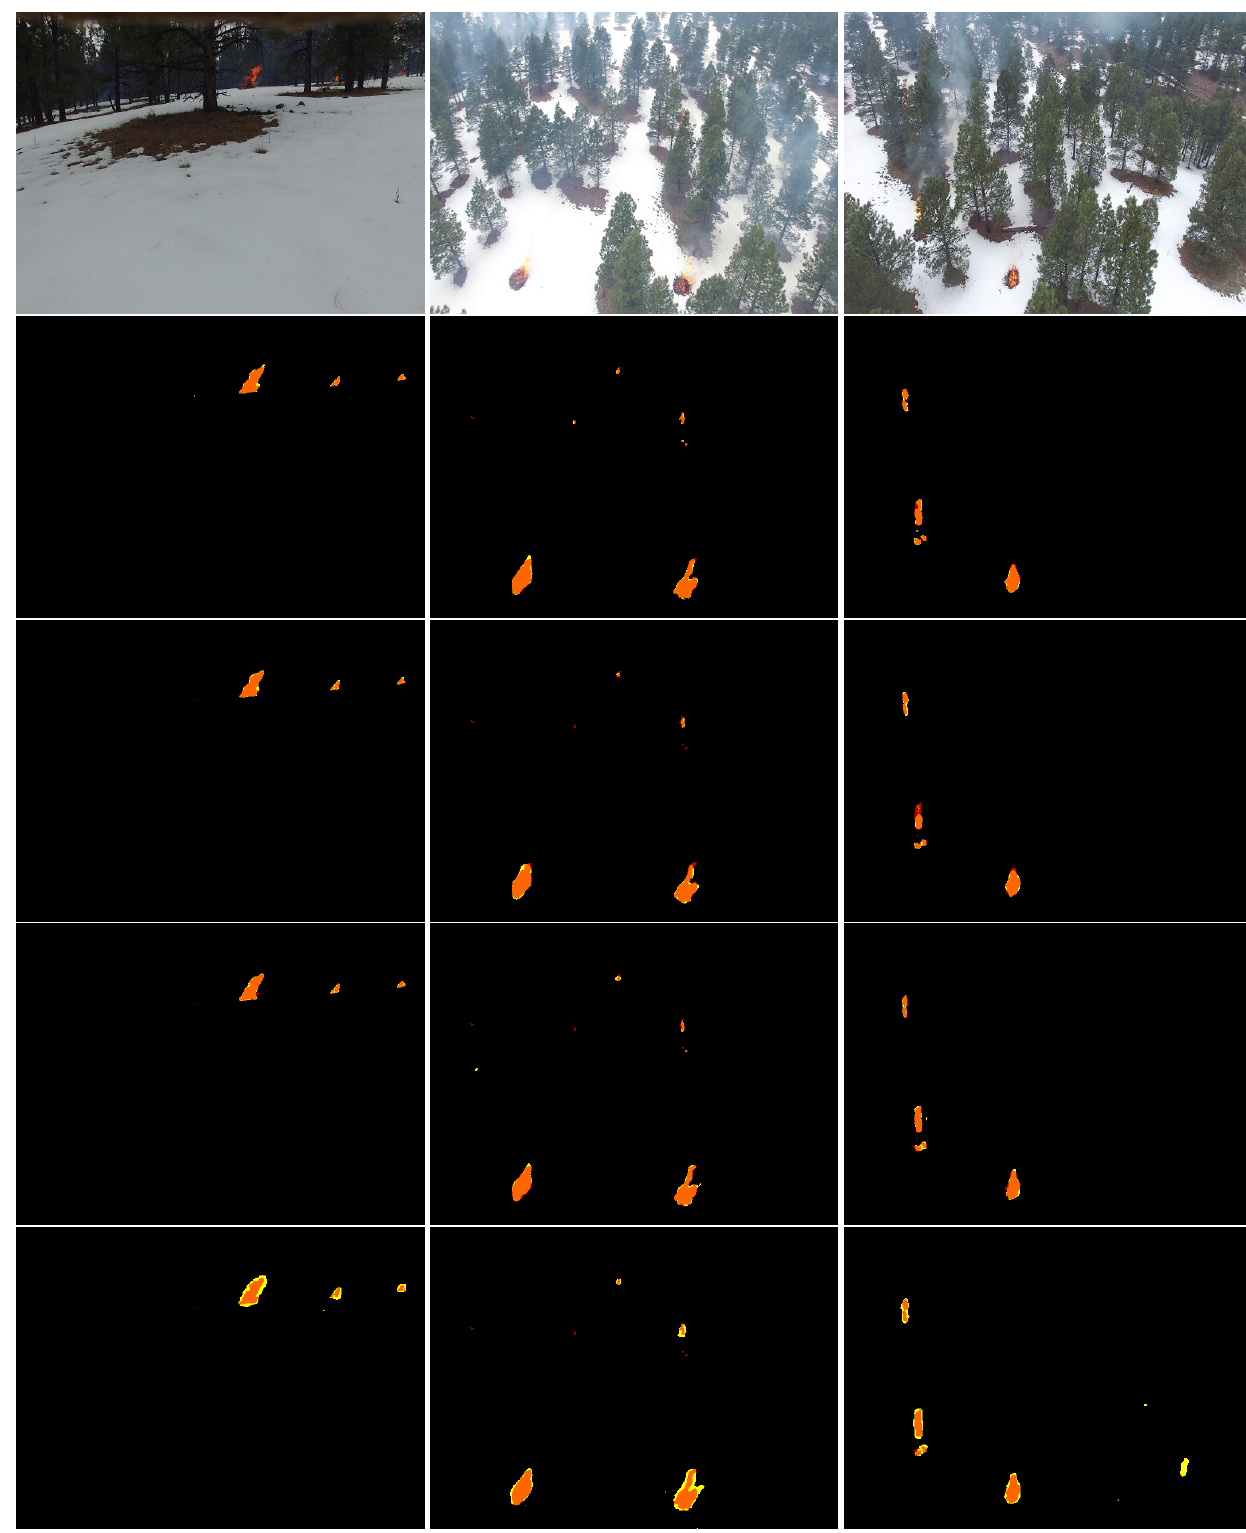
Figure 8. Segmentation results of the proposed models. From top to bottom: RGB aerial images and the results of TransUNet-R50-ViT, TransUNet-ViT, TransFire, and EfficientSeg. Orange represents TP (true positives), yellow depicts FP (false positives), and red shows FN (false